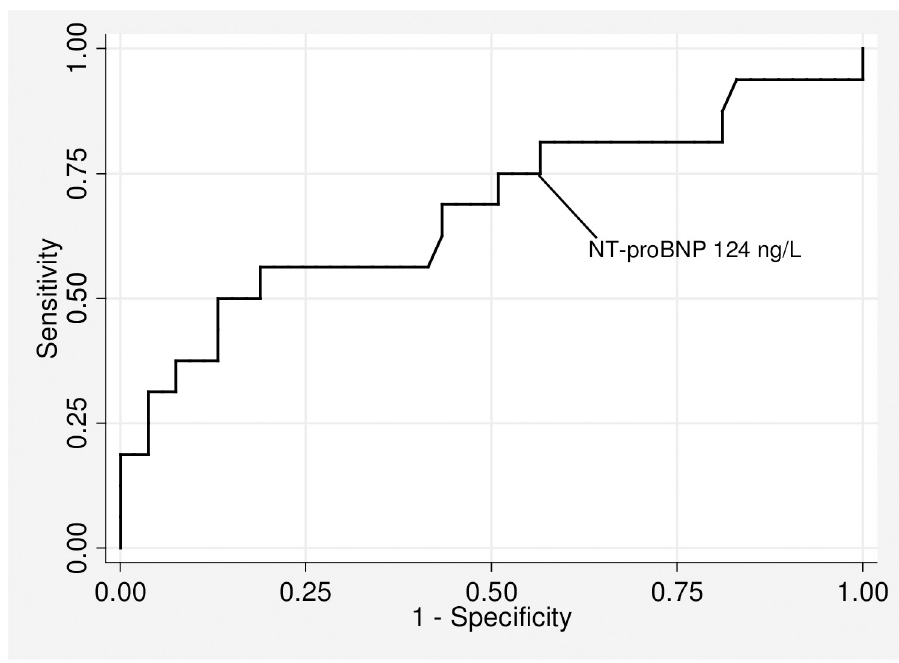
Fig 3. Receiver operating characteristic curve of NT-proBNP plasma level for the detection of new cases of AF.